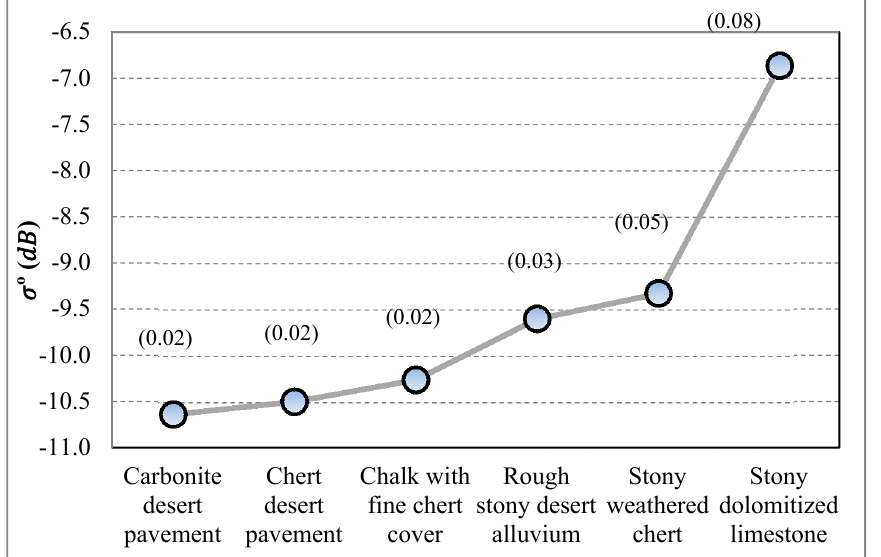
Figure 5. The COSMO-SkyMed average backscatter (dB) of the sampled pixels used to extract the surface roughness of the six selected geomorphological units. In brackets, the Manning’s n values as determined for each unit based on existing literature and fieldwork.